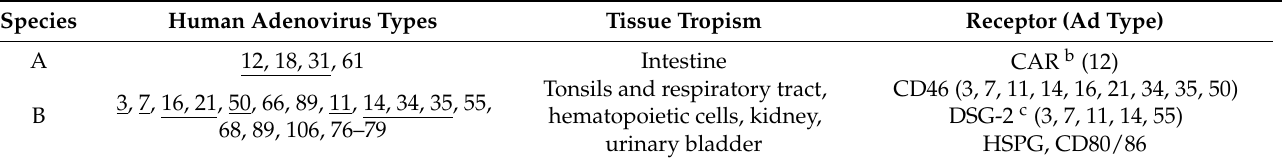
Table 1. Overview of the identified adenovirus types [6–8]. Summarized are the seven adenovirus species, their general tropism and the receptor type. Vectorized adenovirus types according to PubMed records are